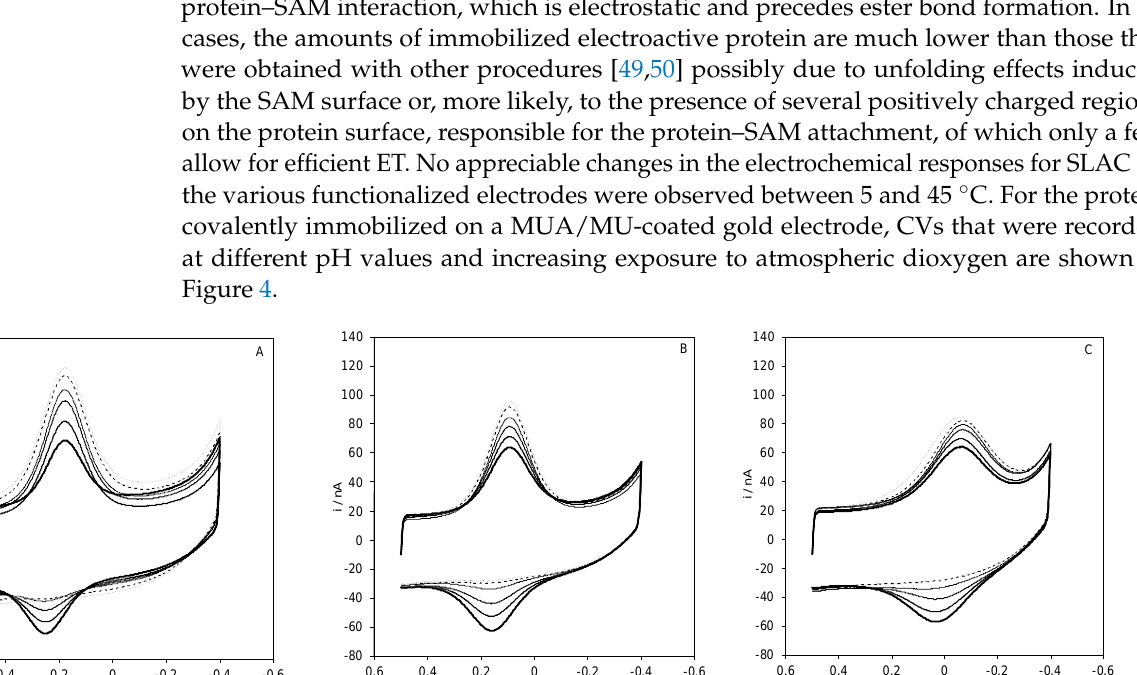
Table 1. Midpoint potential ( E°’), surface coverage values (Γ 0 ), and reduction thermodynamic pa- rameters for Streptomyces coelicolor small laccase (SLAC) immobilized on different functionalized gold electrodes a .